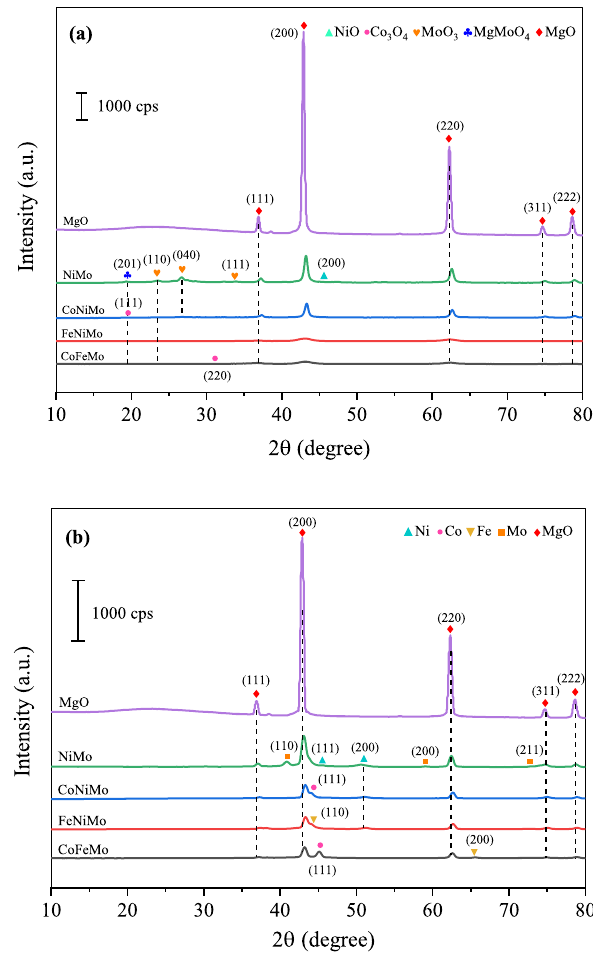
Figure 2. XRD patterns of the fresh catalysts after ( a ) calcination and ( b ) reduction processes.